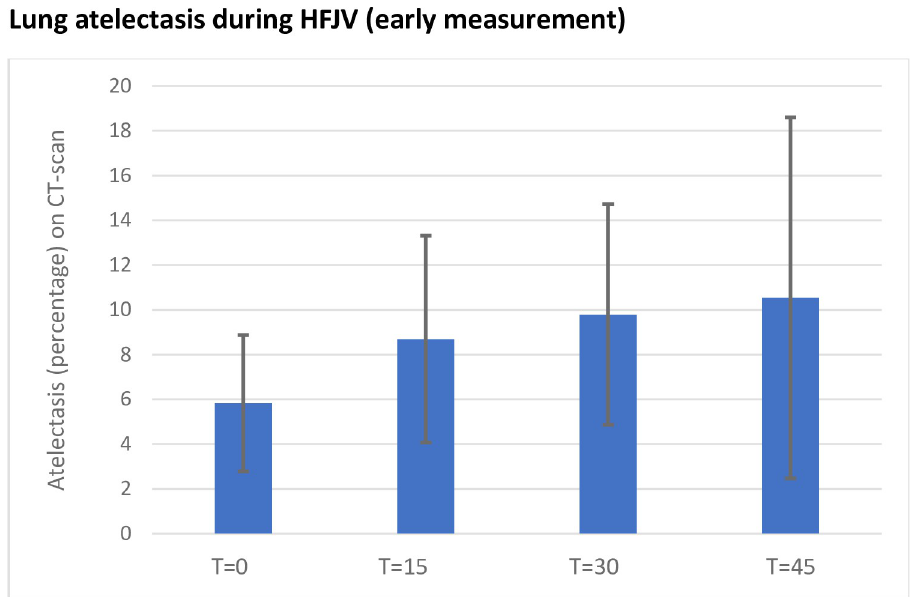
Fig 3. Mean atelectasis in percentage (HU -100-+100) at the four timepoints for the seven patients that started high frequency jet ventilation between 0–5 minutes before the first CT-image. T = 0 being the first CT-scan after initiation of HFJV (high frequency jet ventilation) and thereafter CT-scans every 15 minutes. Significant difference in the amount of atelectasis between groups was seen only at T30 when compared to baseline (p =